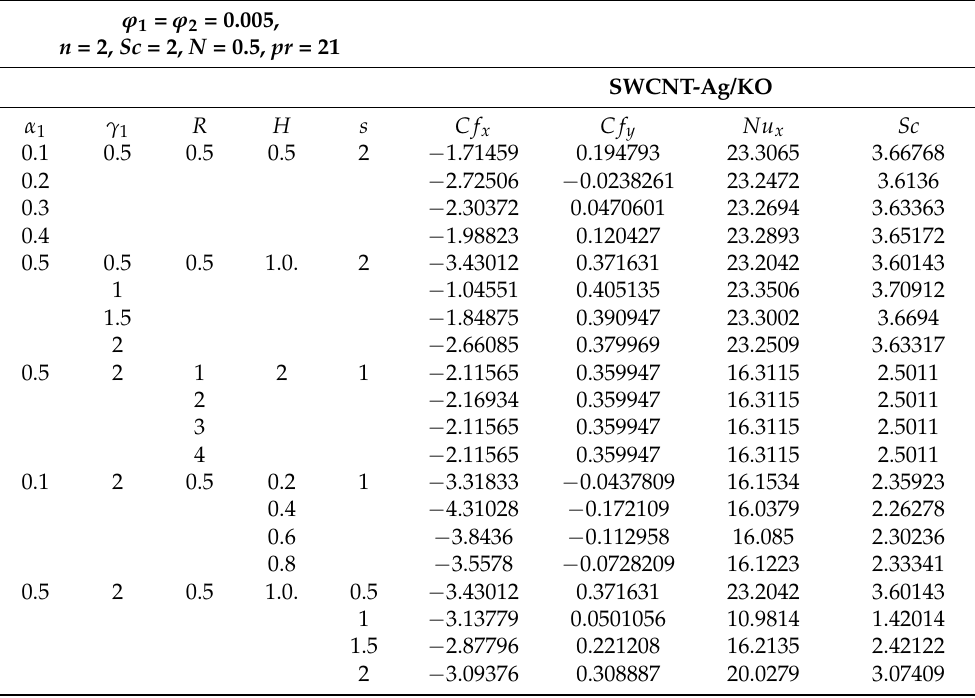
Table 1. The numerical values of skin friction coefficients (Cf x , Cf y ) and Nusselt and Sherwood numbers (Nu x , Sc).